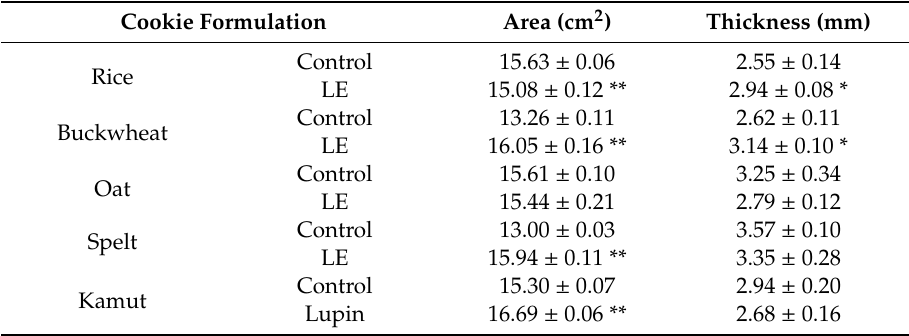
Table 3. The dimensions of each cookie formulation with 10% ( w / w ) of lupin extract (LE). Values are the averages of ten cookies ± SD. * represents p < 0.05 and ** represents p < 0.001 when compared with the corresponding control cookie.